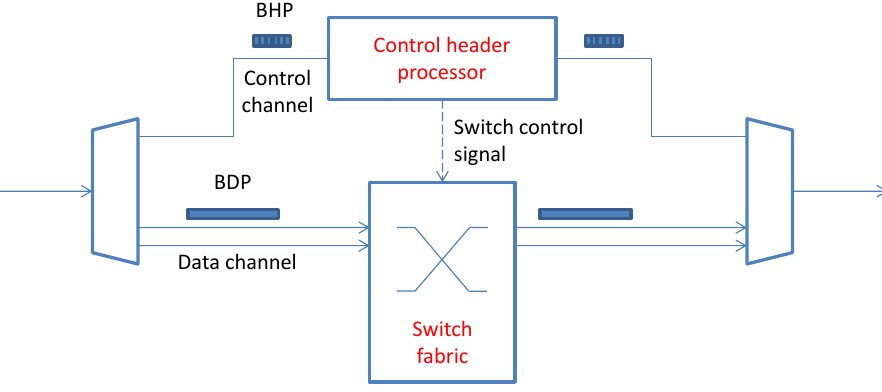
Figure 9. Schematic representation of an OBS router.